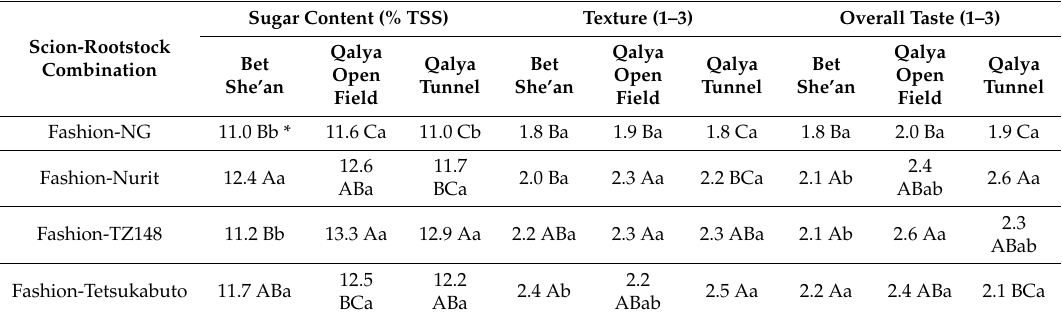
Table 1. The influence of growing locality and rootstock-scion combination on fruit quality parameters after 4 days at 21 ◦ C. Means of 10 fruits per